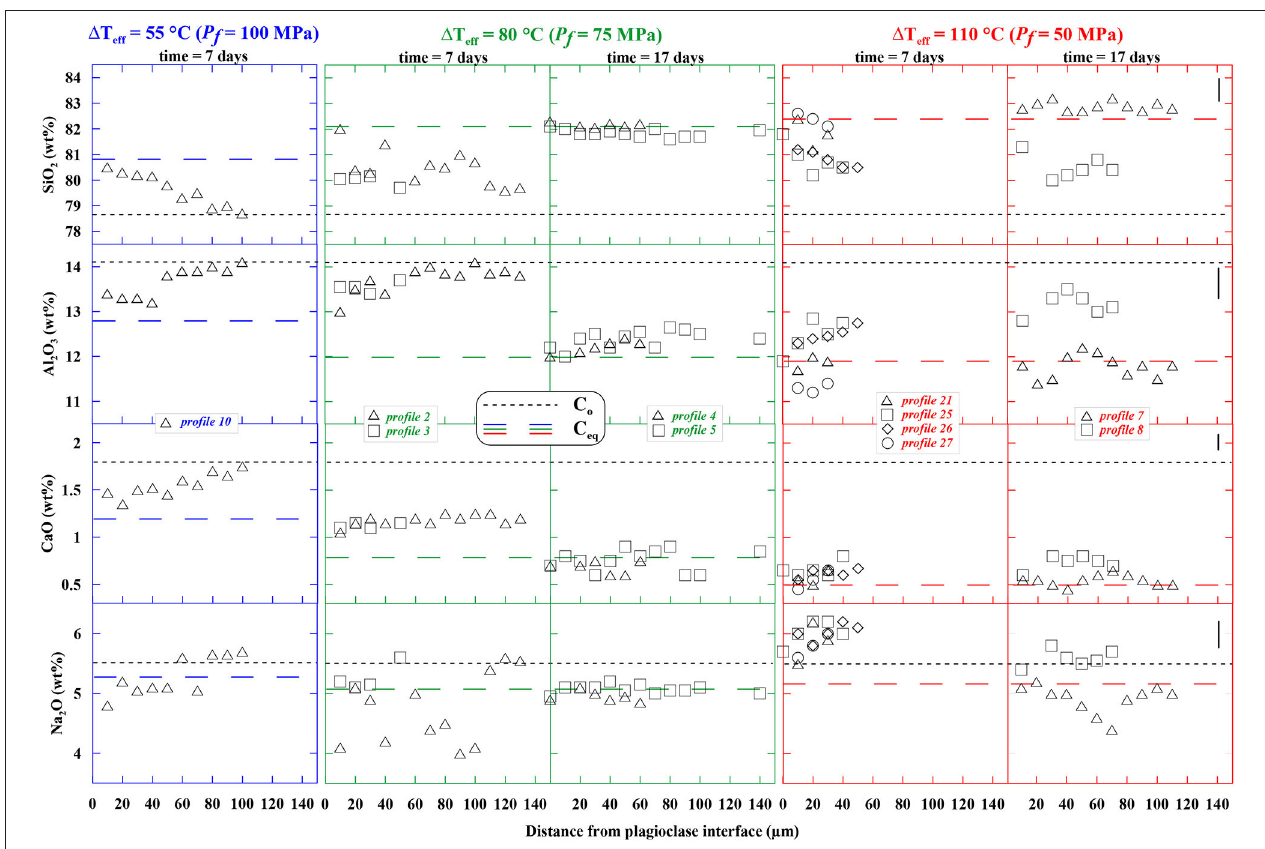
FIGURE 3 | Selected compositional profiles in the glasses from the decompression-induced crystallization experiments of Mollard et al. (2012). Each column corresponds to a given run product at 1 T eff of 55 ◦ C (blue), 80 ◦ C (green), or 110 ◦ C (red), and a crystallization duration of 7 or 17 days. The symbols represent different analytical profiles performed in a given run product. The black dotted lines represent the initial concentrations (C o at 875 ◦ C and 200 MPa) and the colored dashed lines give the expected equilibrium melt compositions at crystallization pressure (C eq at 875 ◦ C and P f ) as given in Table 5 . The vertical bars on the right give the analytical